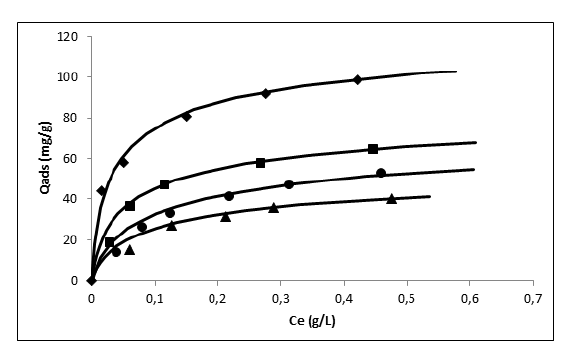
Figure 9. Adsorption isotherms of Chromium ( (cid:31) ), Copper ( (cid:30) ), Iron ( (cid:28) ) and Manganese ( (cid:29) ) over AC(NaOH) at pH=6.5.